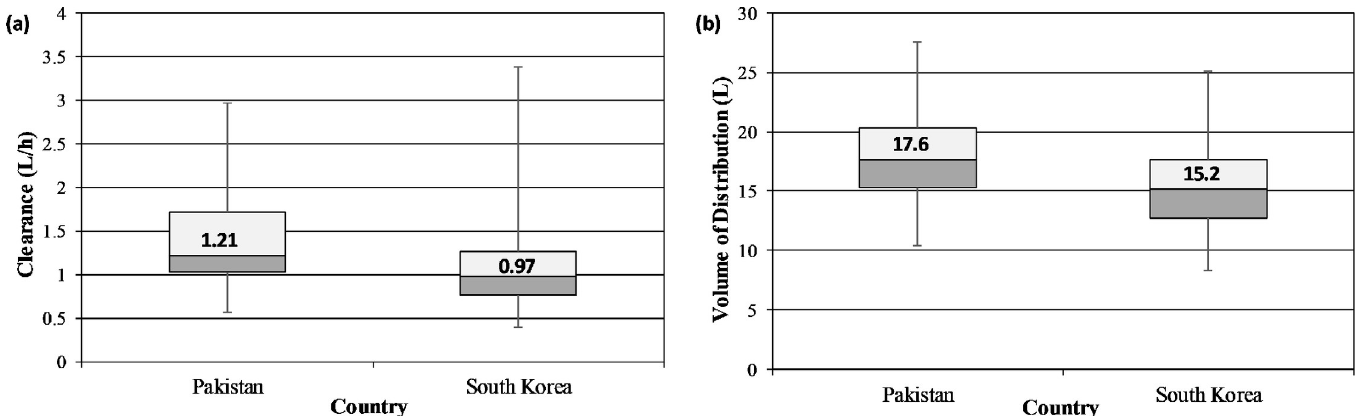
Fig 1. Box-plots showing CL (a) and V d (b) of valproic acid among Pakistani and South Korean patients.